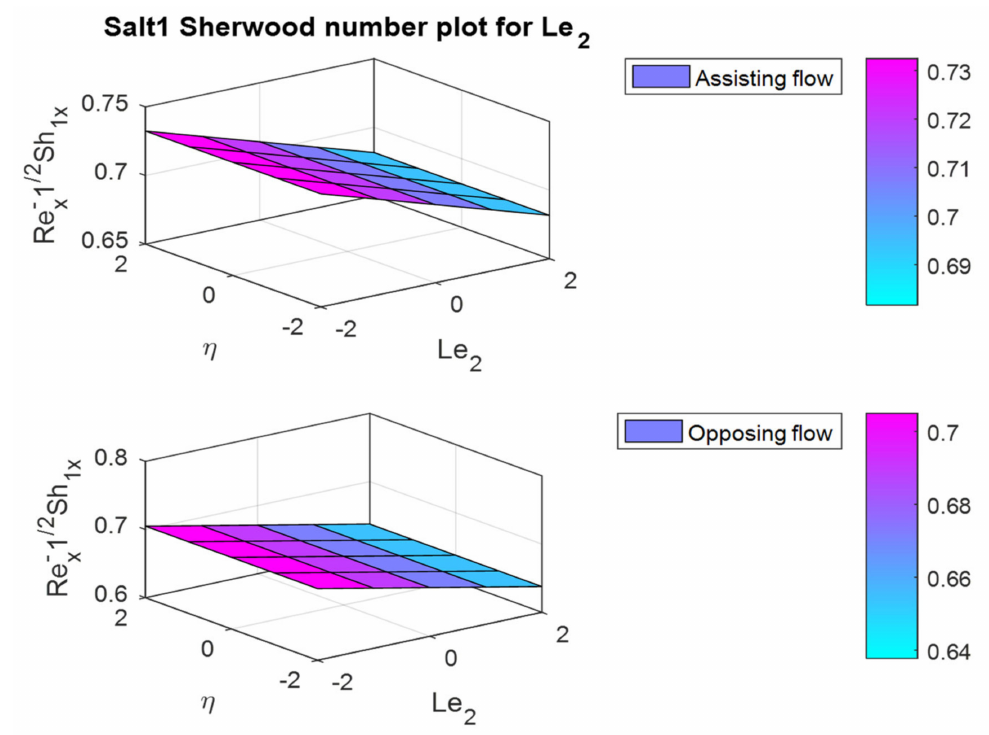
Figure 43. Surface plots for the φ 1 (cid:48) ( 0 ) for dissimilar values of Le 2